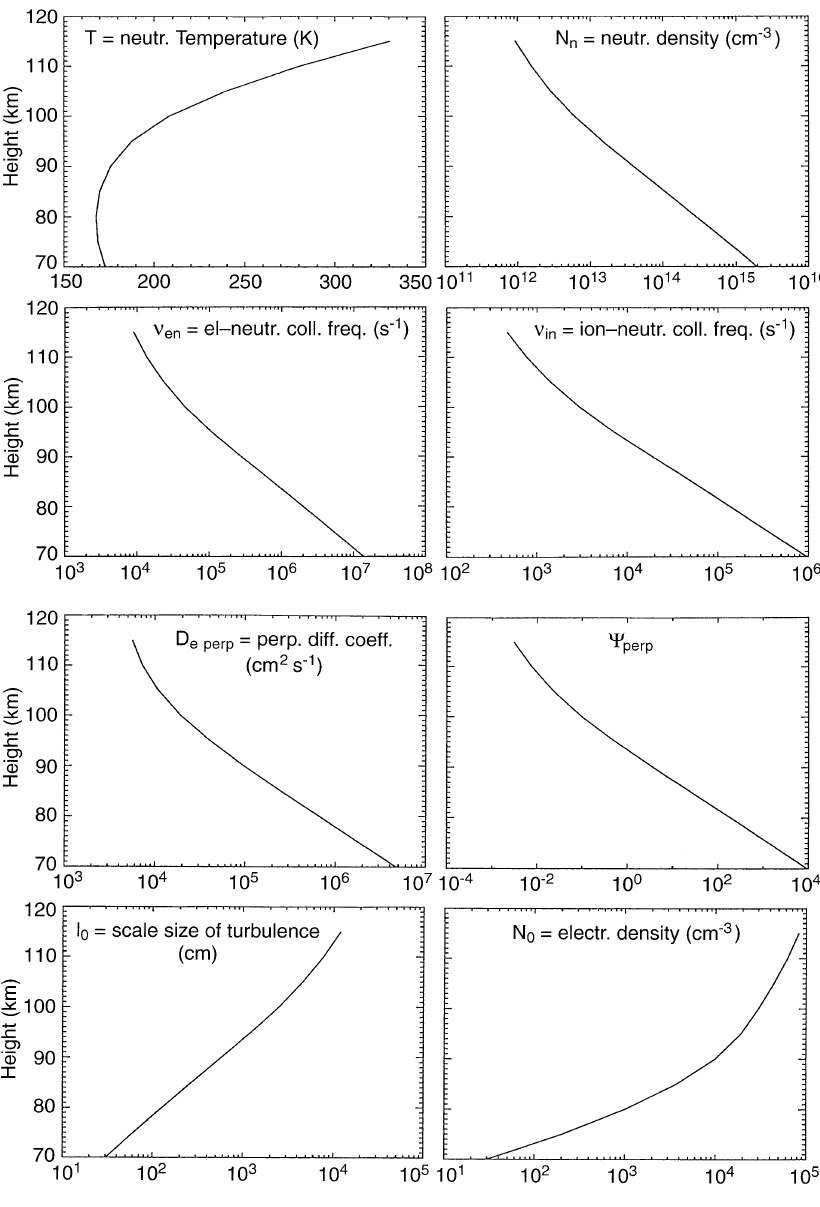
Fig. 1. Height variation of important parameters which enter the backscatter cross- section (Eq.